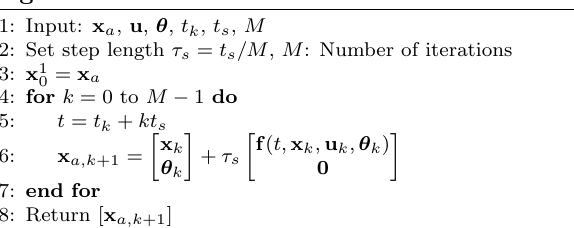
Algorithm 2 Euler-discretization of f